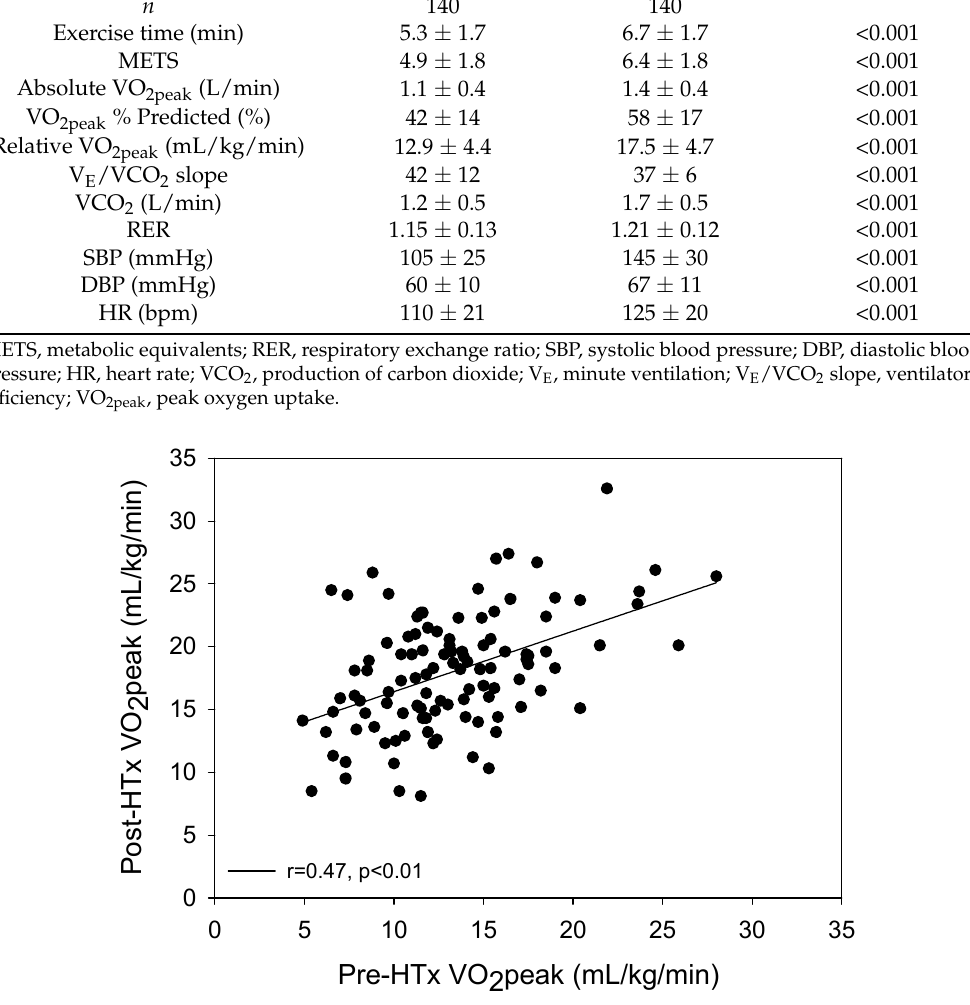
Figure 3. Post-HTx VO 2peak based on median CR exercise session attendance. Those HTx patients who attended ≥ 18 CR exercise sessions had significantly higher post-HTx VO 2peak compared to those with <18 CR exercise sessions attended ( ≥ 18 sessions: 18.8 ± 4.8 vs. <18 sessions: 16.4 ± 4.3, p < 0.01) *, significantly higher than <18 CR sessions. CR: cardiac rehabilitation; Post-HTx: following cardiac transplantation; VO 2peak : peak oxygen uptake. 4. Discussion The purpose of this study was to determine whether pre-HTx clinical characteristics and/or postoperative participation in CR provide utility in predicting VO 2peak following HTx. Pre-HTx VO 2peak and the number of CR exercise sessions attended were the only variables predictive of greater VO 2peak following HTx. These metrics independently predicted higher post-HTx VO 2peak even after adjusting for other factors of exercise capacity, surpassing other significant univariate factors. Our data provide new evidence of the critical benefits of CR in improving functional capacity following HTx.